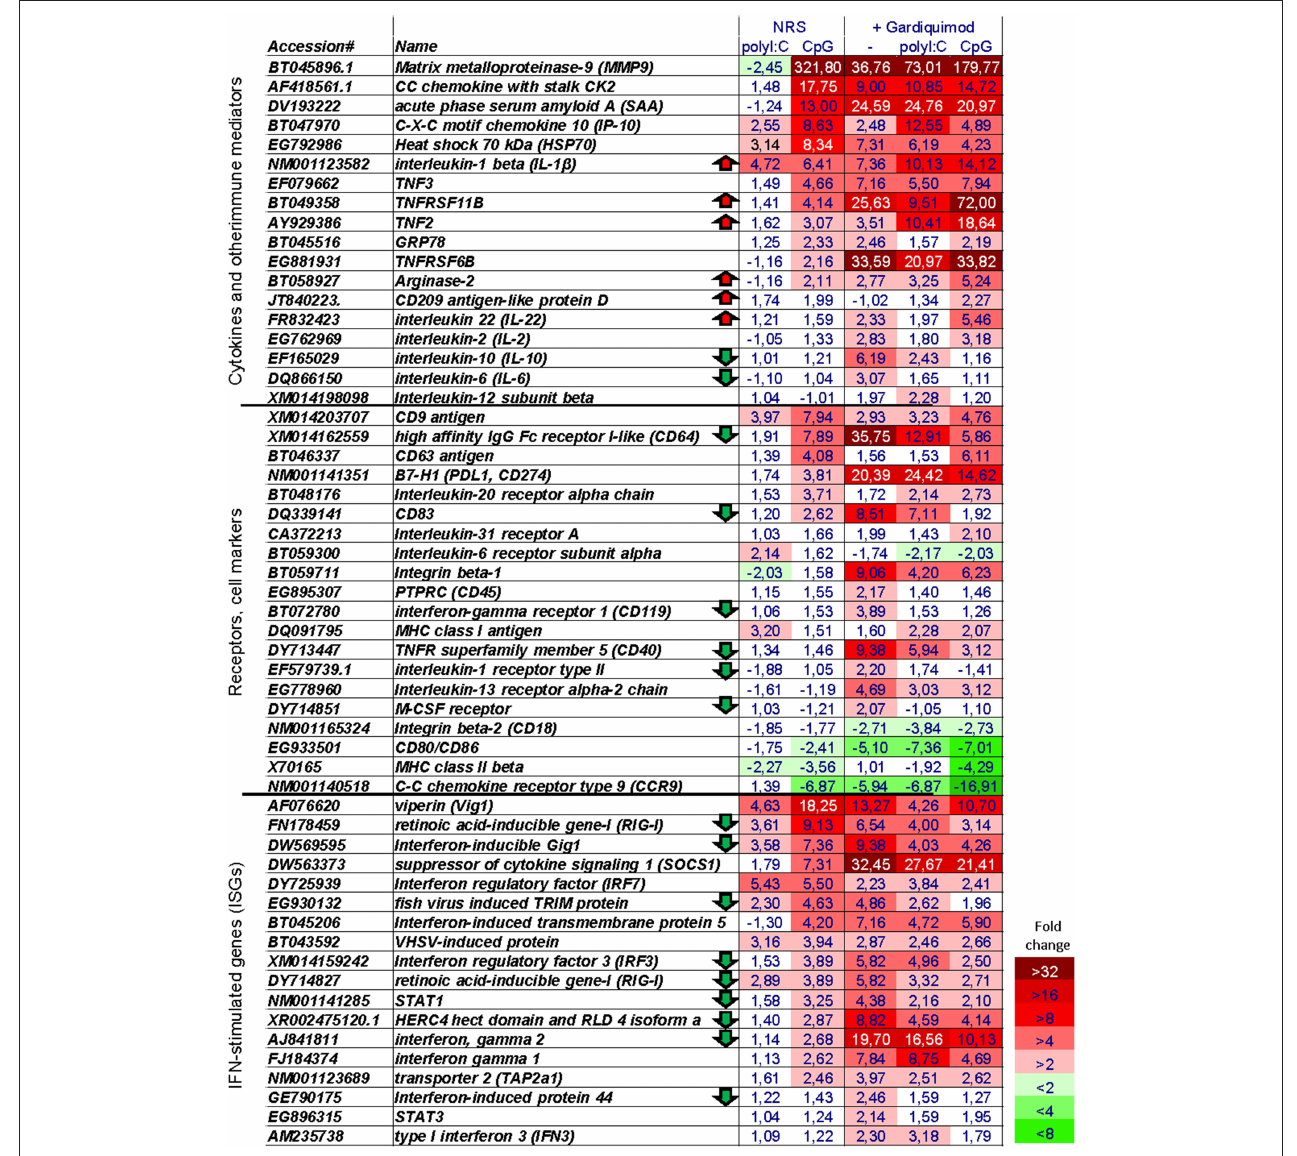
FIGURE 6 | Microarray heat map showing the expression of selected immune genes. The numbers show the “fold change” values as compared to non-stimulated cells. The heat map legend is shown in the lower right corner. Note, that genes of interest have been tentatively assigned to three groups; however, many of them can be assigned to more than one group. Arrows indicate genes whose expression is at least 1.9-fold higher or lower in CpG + Gardiquimod samples as compared to samples stimulated only with